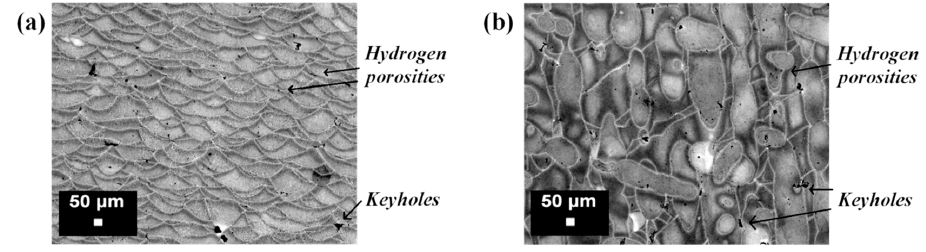
Figure 11. Optical images of an AlSi10Mg microstructure after Keller’s etching: ( a ) vertical section; ( b ) horizontal section. The metallurgical pores (hydrogen porosities) and the keyhole defects are indicated in the micrographs.